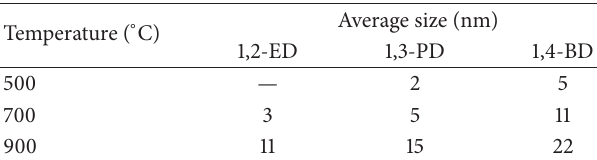
Table 1: Average diameters of CoFe 2 O 4 crystallites calculated according to the Scherrer